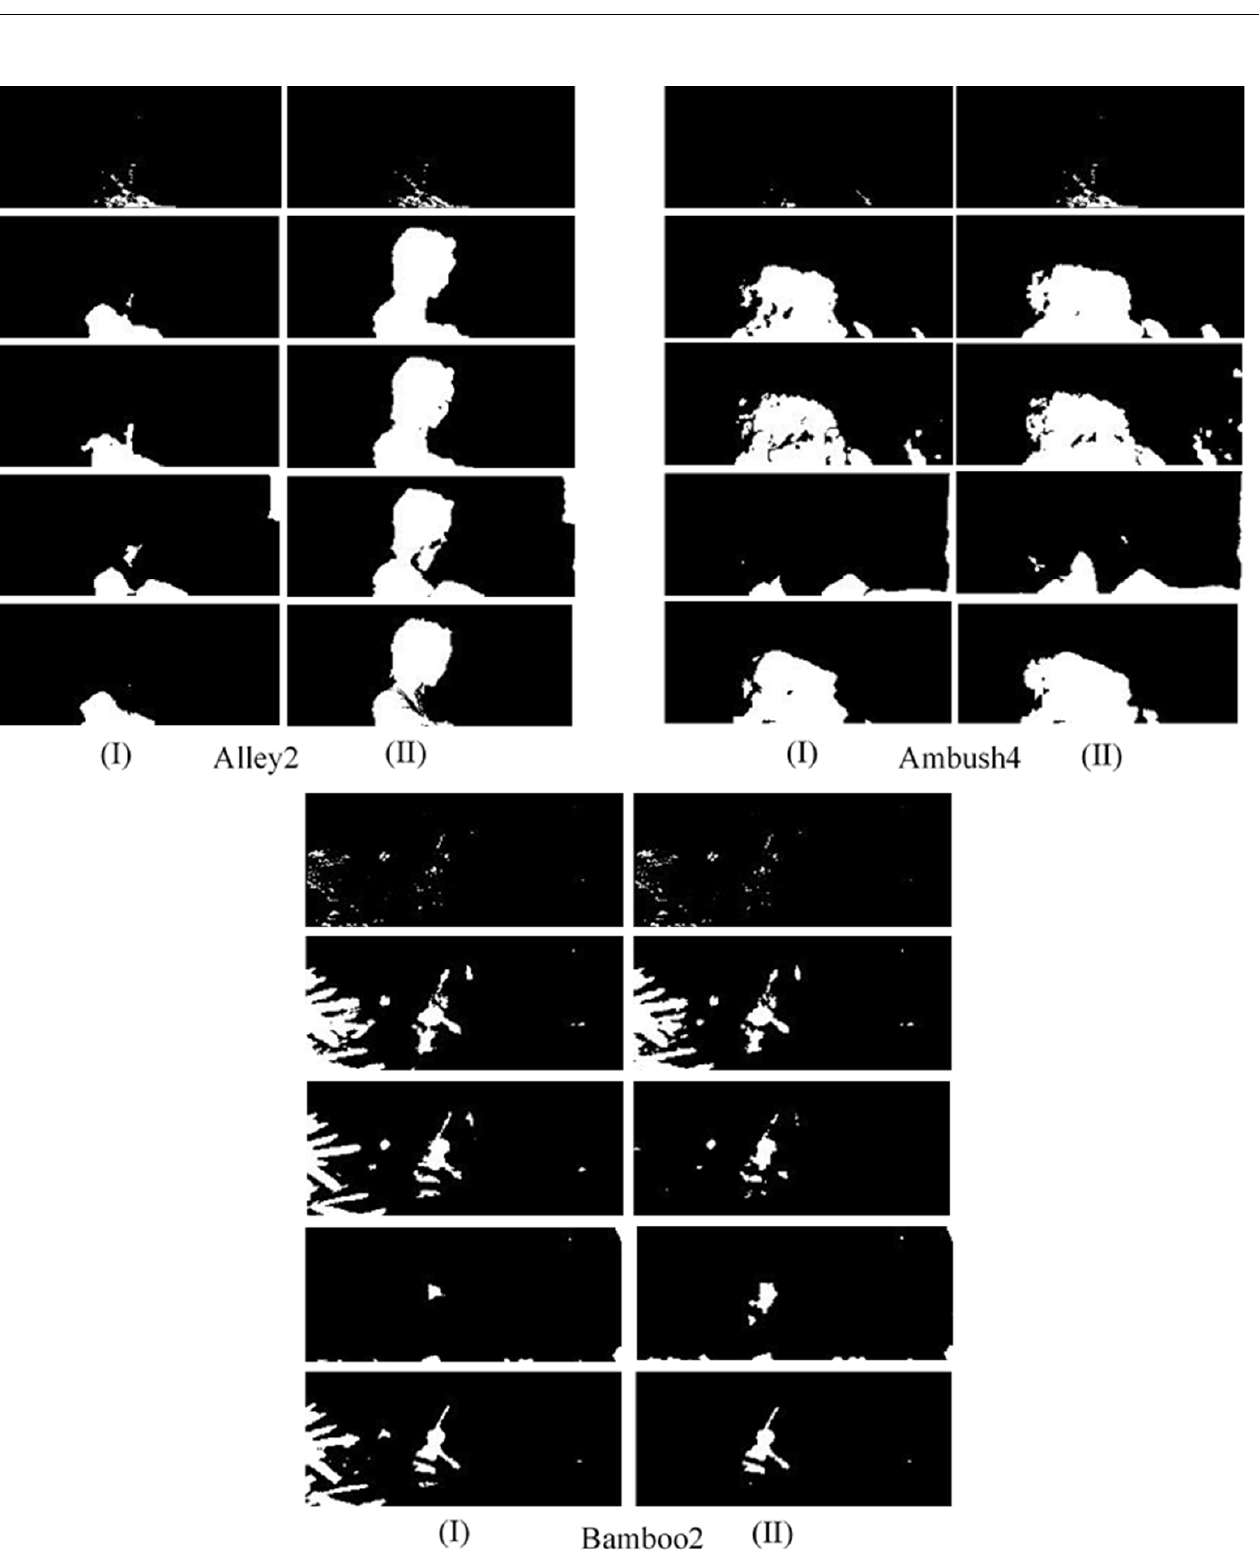
Figure 8. Comparison of the extraction results in a single moving target scene. ( I ) Otsu results and ( II ) our thresholding results. The top-to-bottom regions depict the LK result, HS result, B&A result, Brox result, and this study’s result.